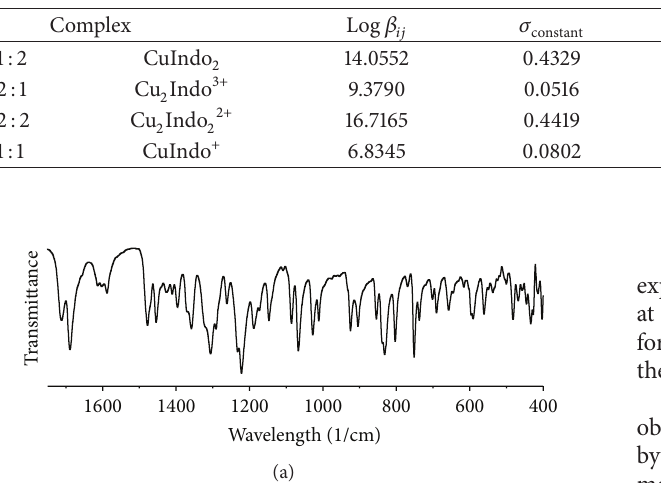
Table 1: Logarithms of the global formation constants, log 𝛽 𝑖𝑗 , with their standard deviations 𝜎 constant , as well as the statistical parameters 𝜎 data and U of the Cu(II) – Indomethacin complexes determined in water or ethanol.